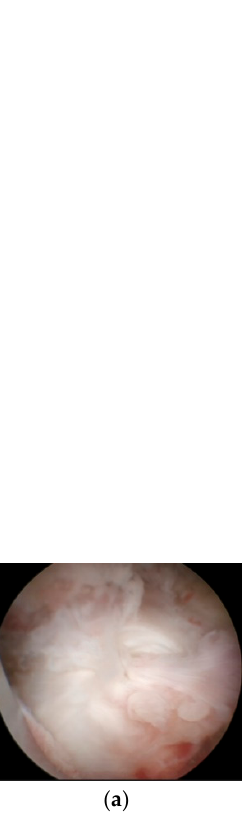
Figure 1. ( a ) Facet joint capsule must be preserved. ( b ) Laminotomy using endoscopic burr starting from inferior border of upper lamina. ( c ) Ligamentum flavum removed with Kerrison rongeur. ( d ) Lateral border of traversing nerve root is visualized.